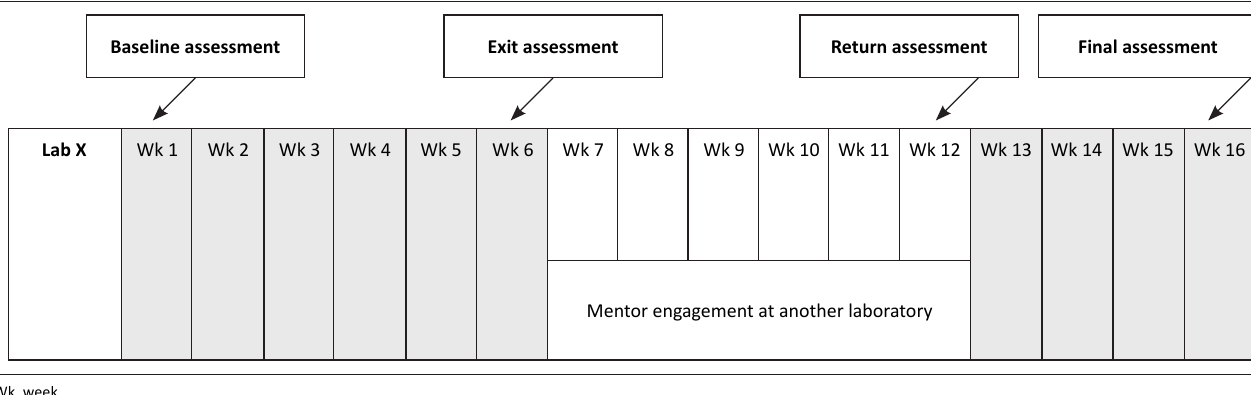
FIGURE 1: Schematic representation of the 10 weeks of mentorship split into two blocks of six and four weeks with six to eight weeks in